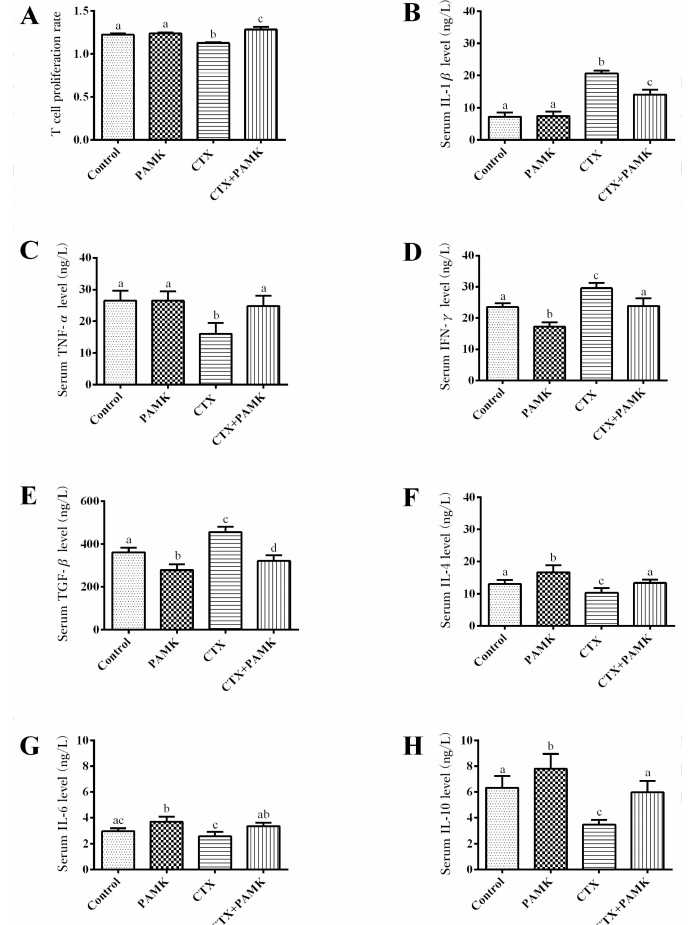
Figure 6. Effects of PAMK on the cellular immunity of geese treated with CTX. ( A ) T-cell proliferation rates; ( B ) Serum IL-1 β levels; ( C ) Serum TNF- β levels; ( D ) Serum IFN- γ levels; ( E ) Serum TGF- β levels; ( F ) Serum IL-4 levels; ( G ) Serum IL-6 levels; ( H ) Serum IL-10 levels. The data are expressed as the mean ± SD, n = 8. Means with different letters represent statistically significant differences ( p < 0.05); the bars with the same letter are not significantly different ( p >